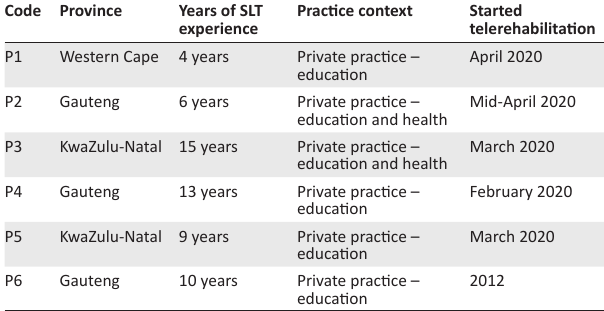
TABLE 1: Description of the participants